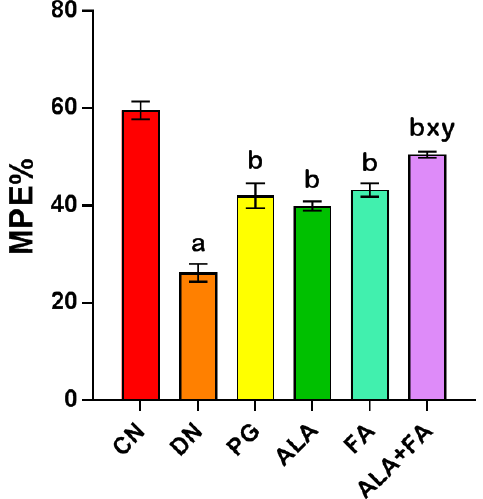
Figure 2. Effect of ALA, FA, and their combination of heat (thermal) hyperalgesia using Eddy’s hot plate in diabetic neuropathy induced rats (measured on the sixth